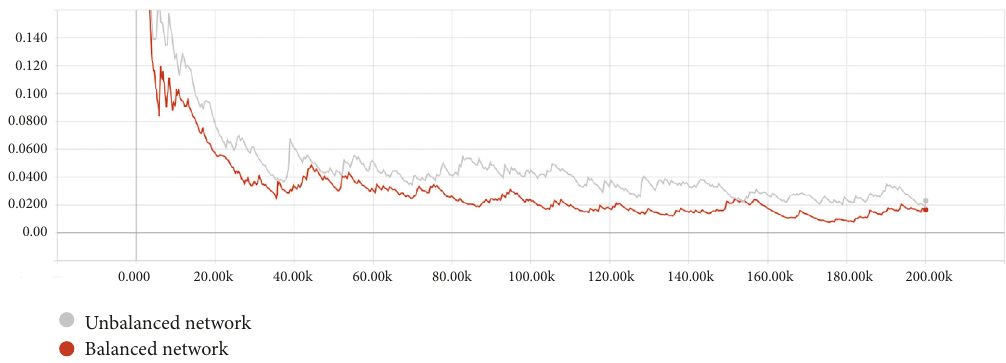
Figure 8: Balanced and unbalanced